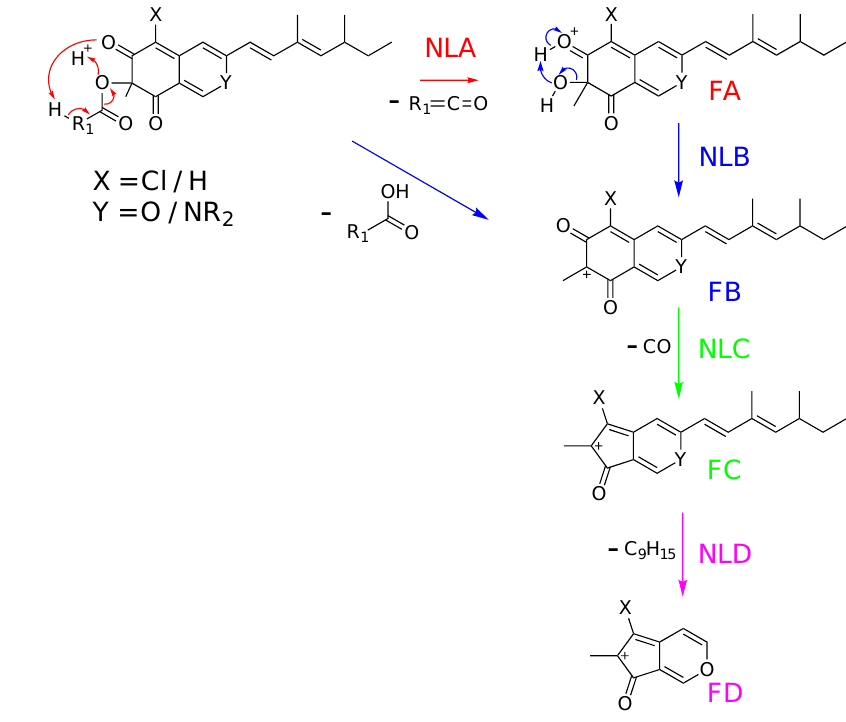
Figure 5. Annotation of cluster B with hypothetical structures proposed from molecular network data. In red and blue are molecules identified directly in MN (sclerotioramine ( 2 ), isochromophilone VI ( 5 ), isochromophilone IX ( 6 ), penazaphilone F ( 19 ) and penazaphilone D ( 20 )), in black are molecules annotated with MS/MS. First, cluster A, containing annotated sclerotiorin ( 1 ), isochromophilone IV ( 21 ) and sclerketide B isomer ( 22 ), was clearly separated from others on the t-SNE molecular net-